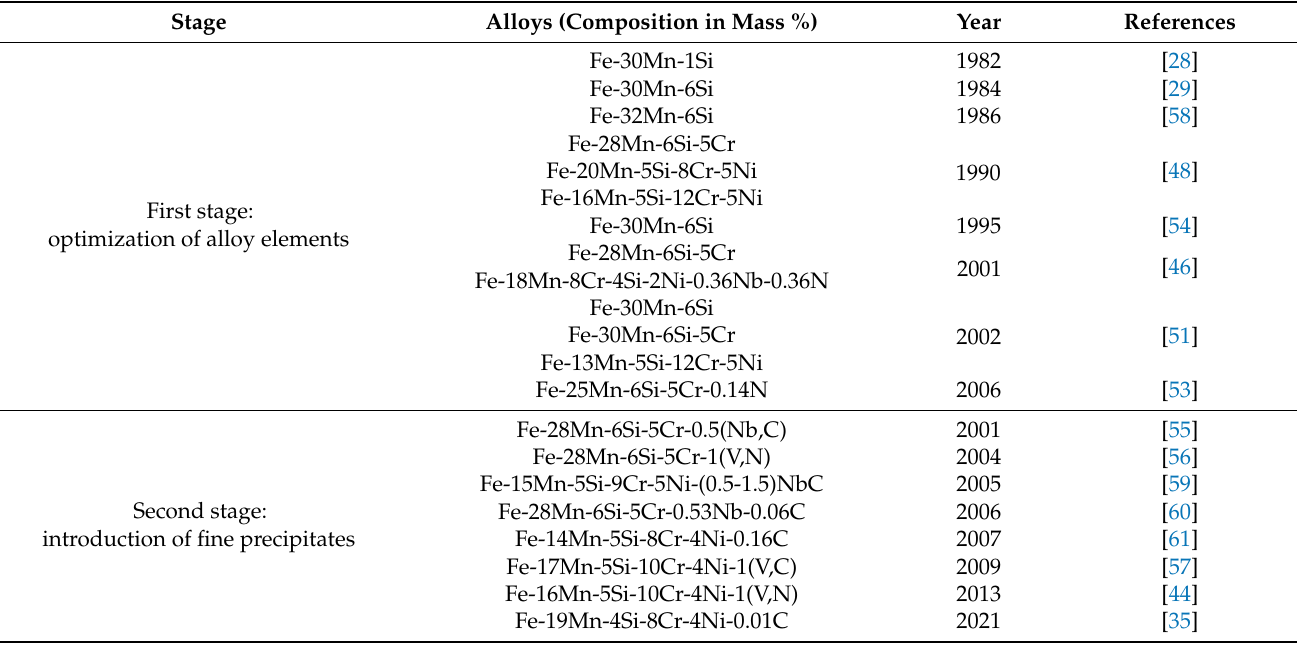
Table 1. The most significant Fe-Mn-Si alloys in the development